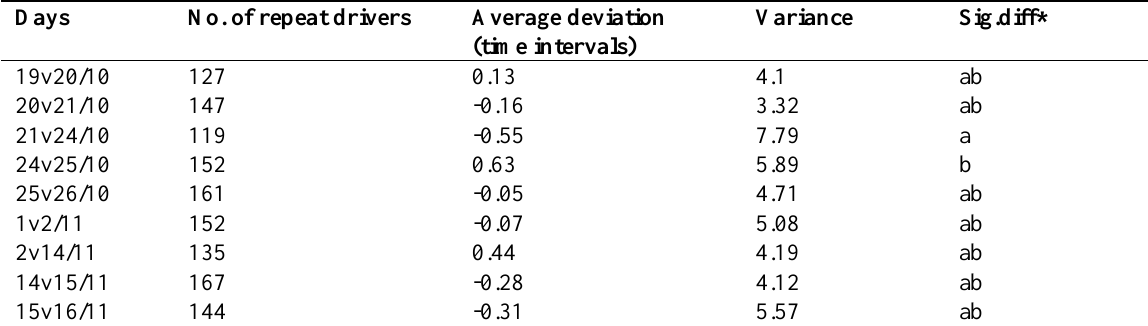
Table 4. ANOVA on the effect of day on the average deviations in arrival time (number of 5 minute time slot differences) for repeat journeys during the 1994 Winchester Road survey.